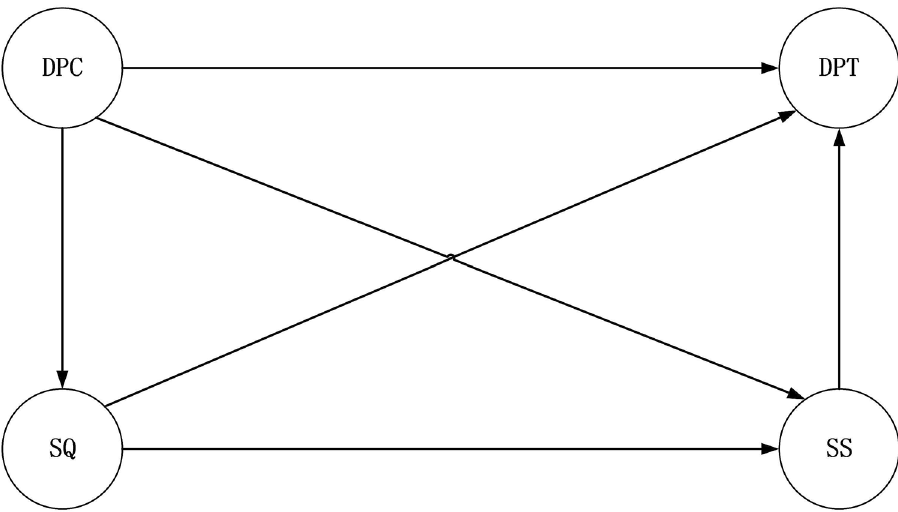
Figure 1. The research model based on the hypotheses. DPC doctor–patient communication, SQ service quality, SS service satisfaction, DPT doctor–patient